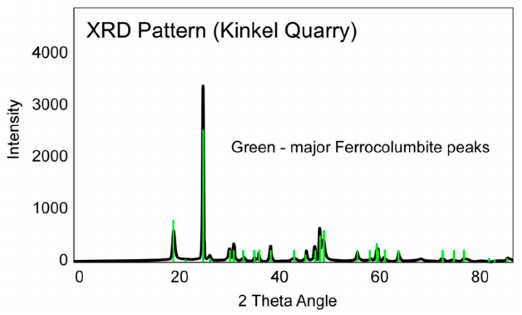
Figure 2. Representative X-ray diffractogram for Columbite-(Fe) sample from the Kinkel pegmatite.